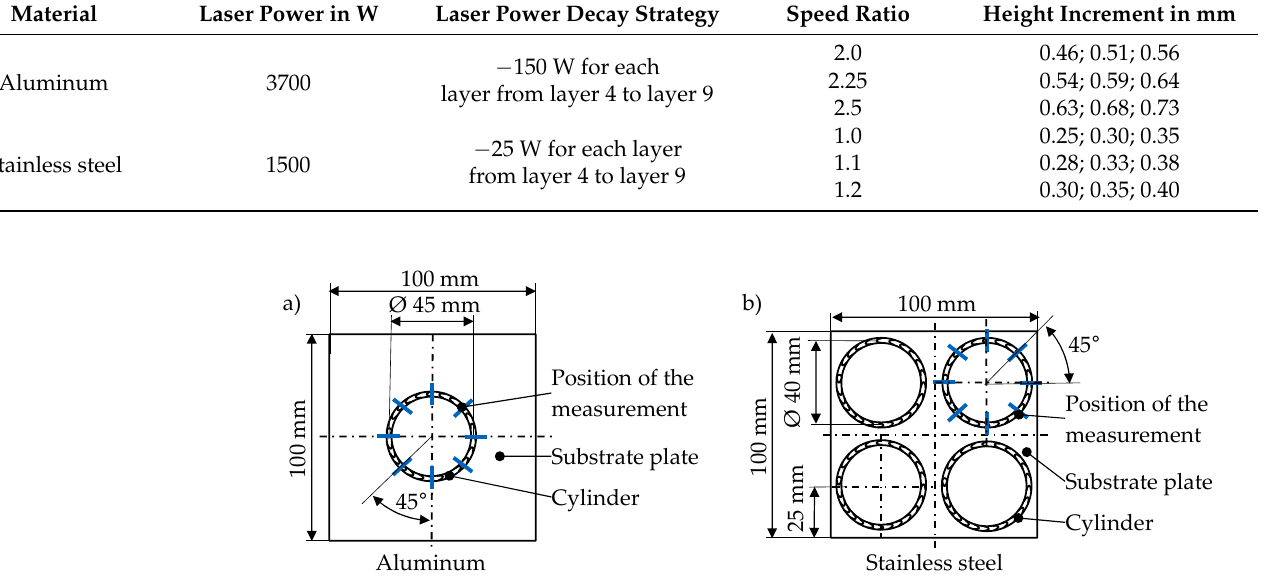
Figure 4. Schematic depiction of the cylindrical specimens produced with ( a ) aluminum and ( b ) stainless steel.